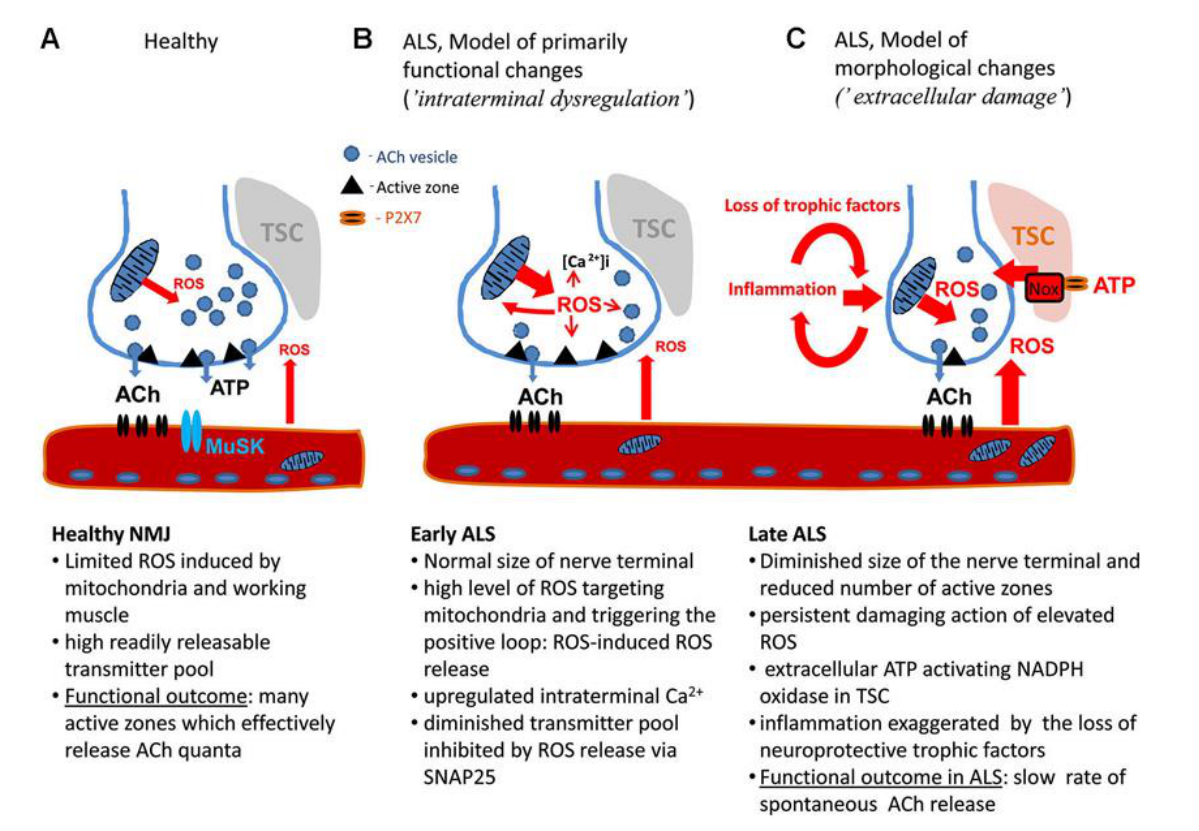
Figure 4. The model of motor nerve terminal dysregulation in ALS. ( A ) Healthy NMJ. ( B ) Pathological changes in NMJ during early stage of ALS. ( C ) Pathological changes in NMJ during late stage of ALS. Abbreviations: Ach — acetyl choline, MuSK — muscle-specific kinase, NMJ — neuromuscular junction,